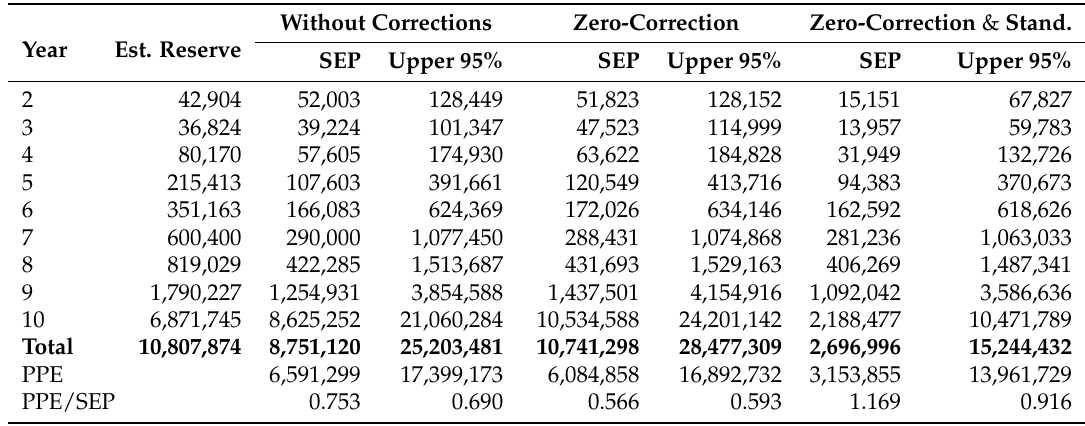
Table 6. Log-normal model with Pearson